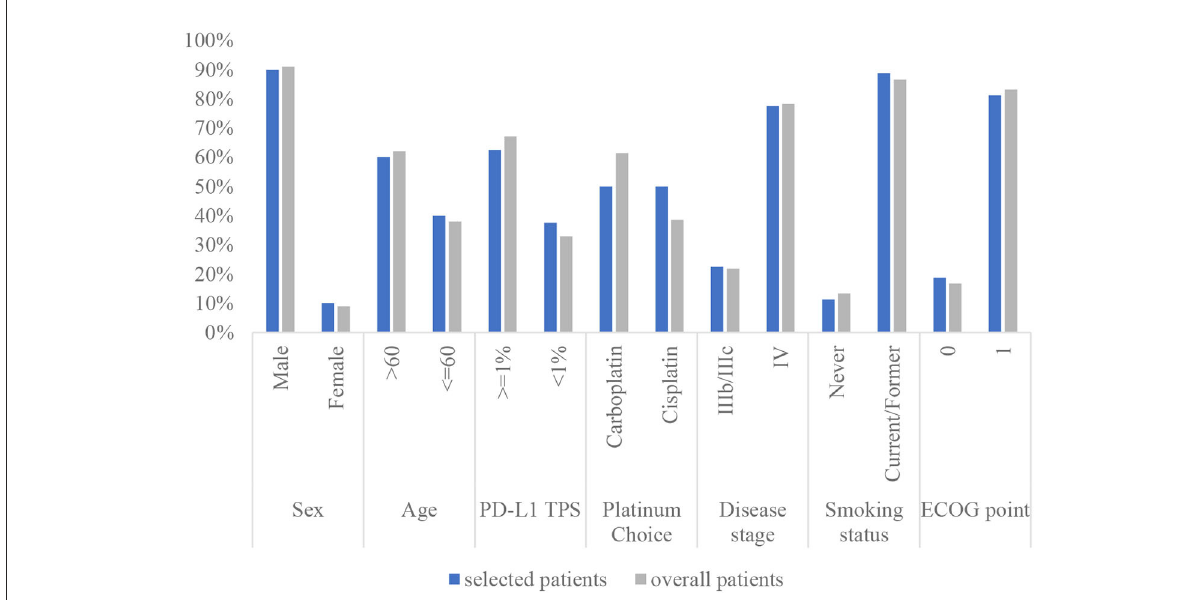
FIGURE2 The characteristics of the selected patients compared with that of the overall patients in the clinical trial. PD-L1 TPS, programmed cell death-1 tumor proportion score; ECOG PS, Eastern Cooperative Oncology Group performance